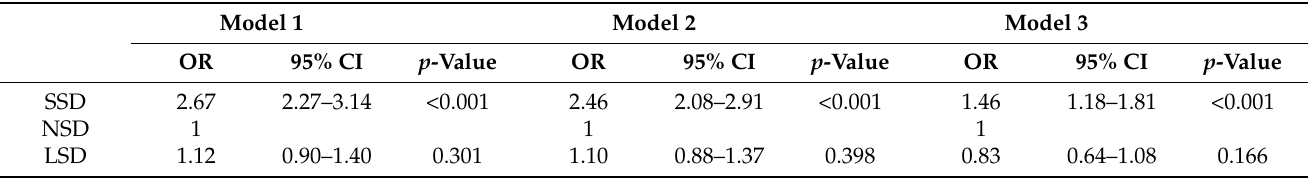
Table 2. Association between sleep duration and suicidal Table 1. Baseline characteristics according to sleep duration for the study population.